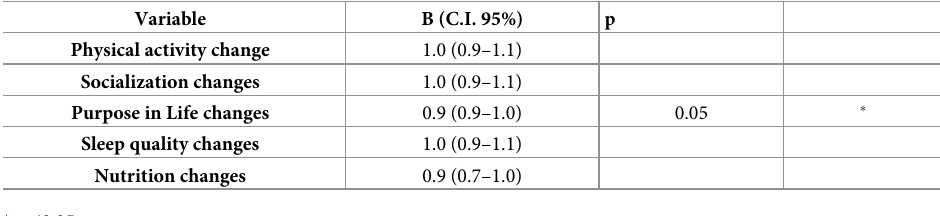
Table 10. Multiple logistic binomial regression using new diagnosis of depression as dependent variable, lifestyles changes at follow-up as independent variables, and gender and age as covariates. Reported values are standardized